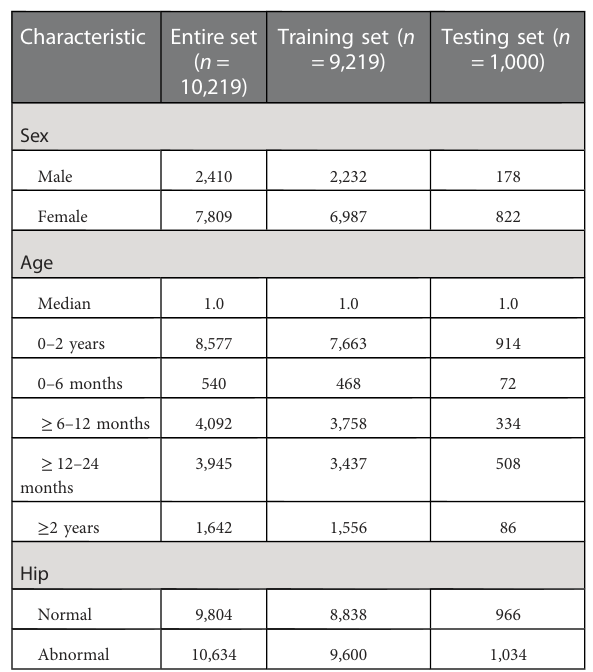
TABLE 1 Clinical characteristics of the study participants.